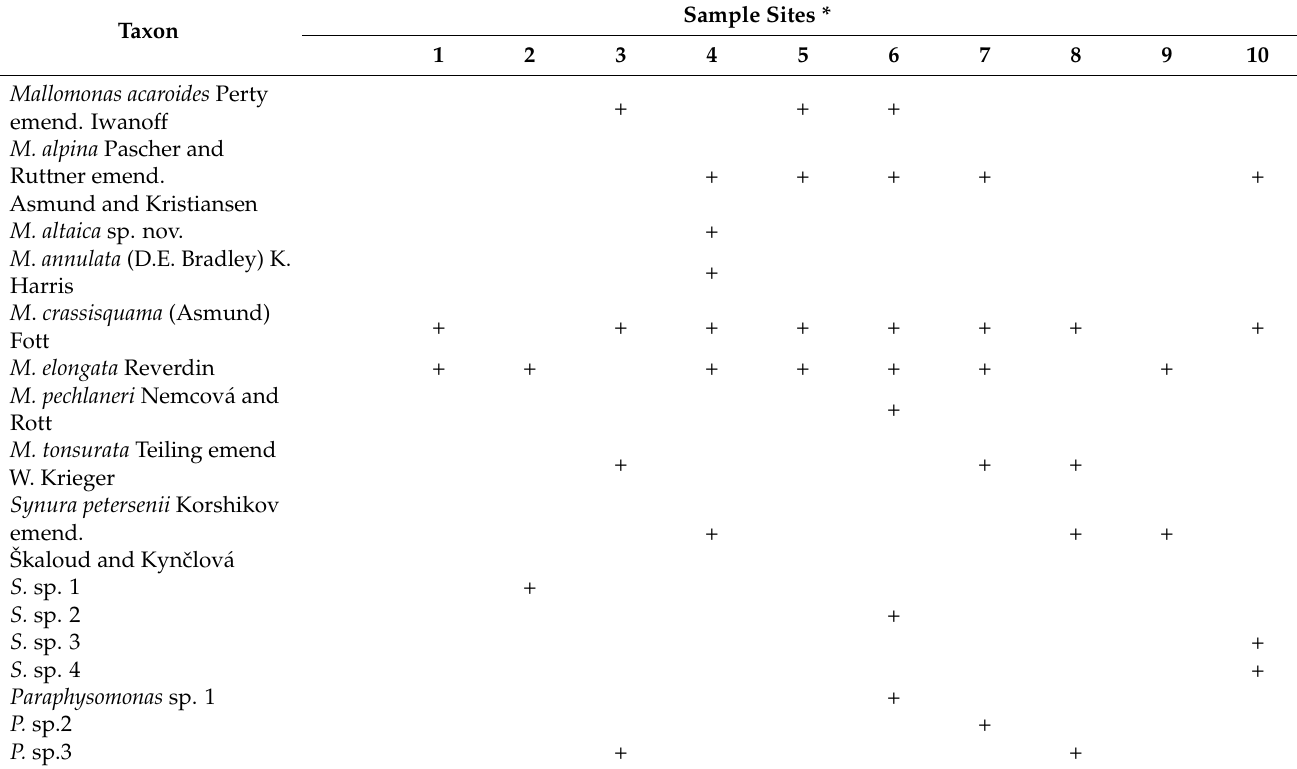
Table 2. List of silica-scaled chrysophytes found in this study; “+” indicates the presence of a